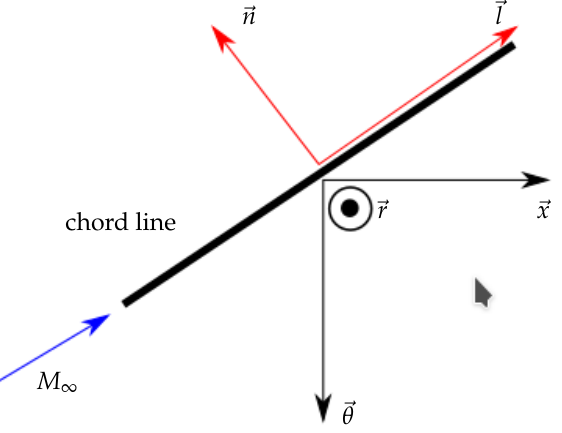
Figure 4. Illustration of used coordinate system of the acoustic engine noise